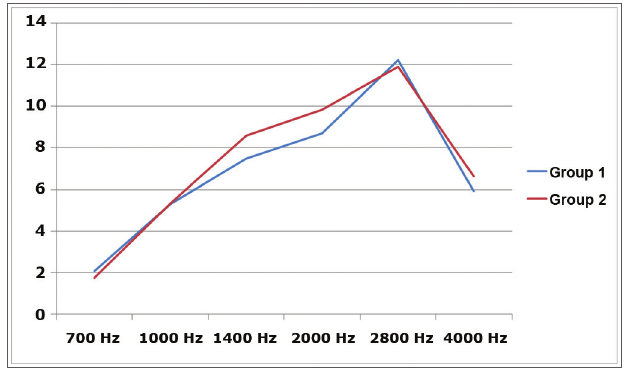
Figure 3. TOAE (dB SPL x Hz) in both